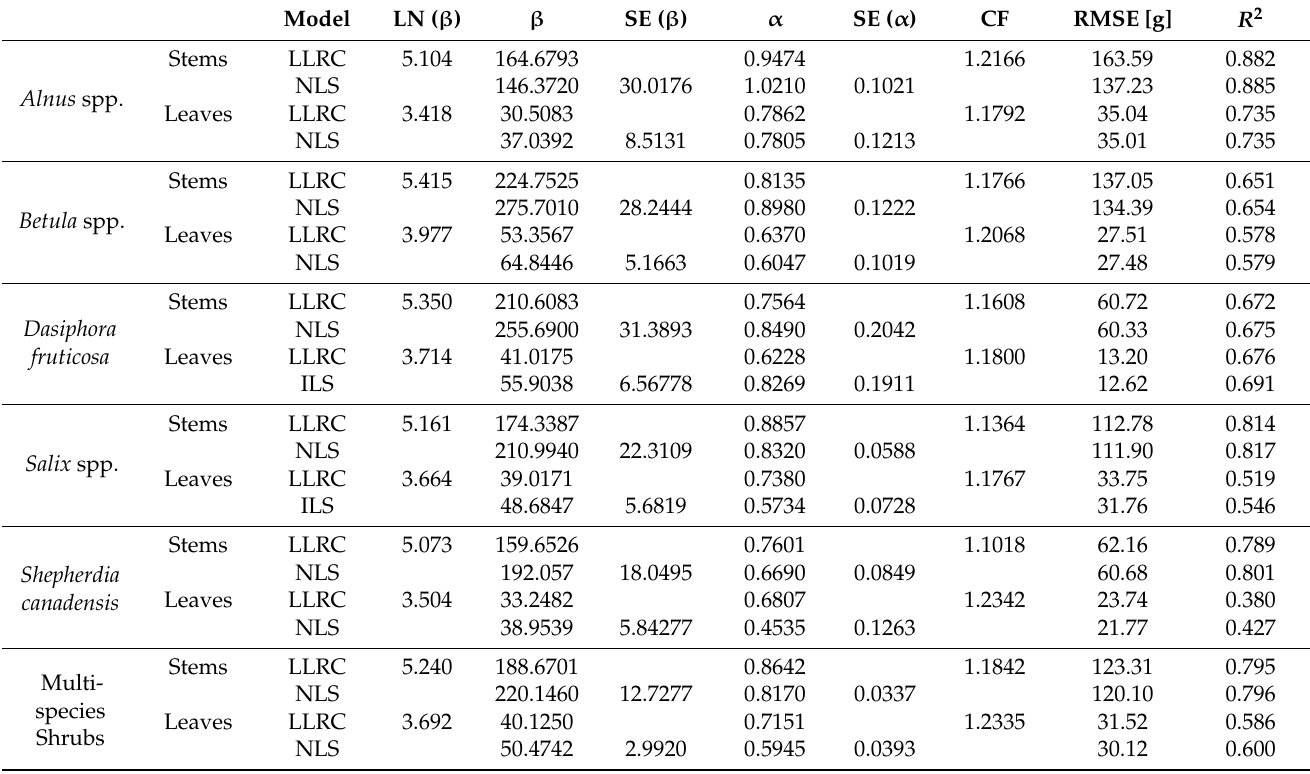
Table 2. Volume-based regression coefficient estimates with error statistics to be input into Equations (2)–(5) as appropriate to derive shrub component